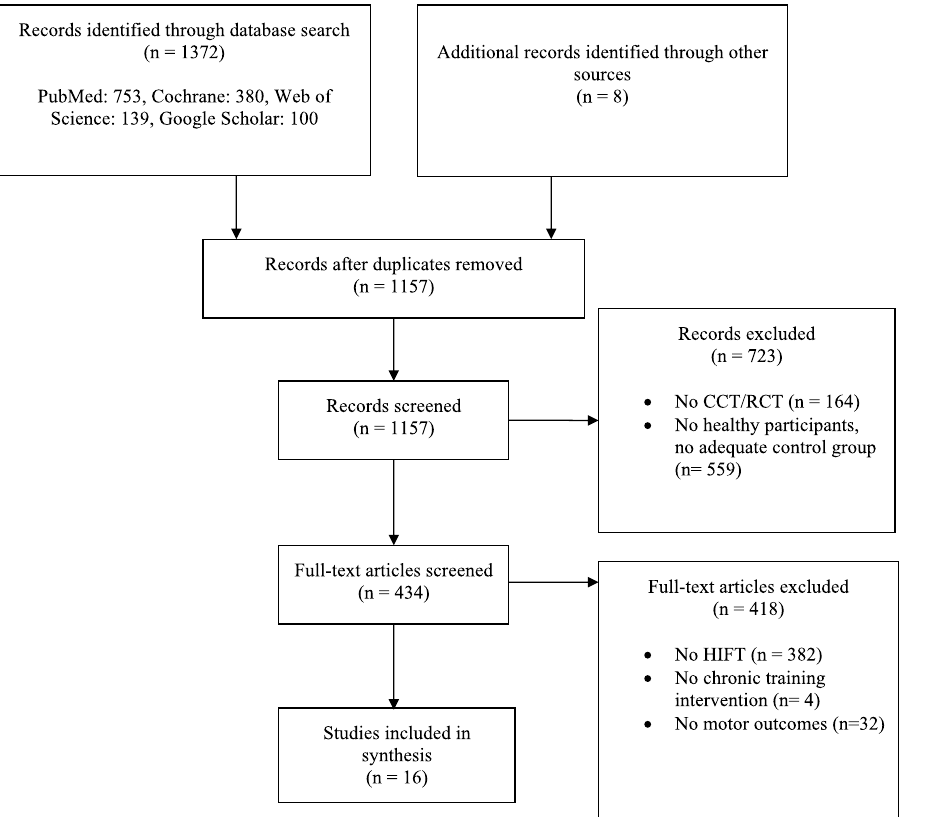
Figure 1. PRISMA chart of the study flow. CCT controlled clinical trial, RCT randomized controlled trial, HIFT high-intensity functional